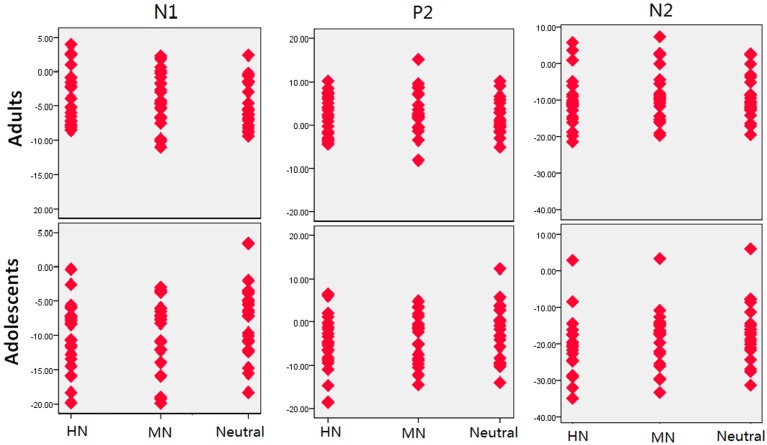
The scatterplot for the breakdown of the age and emotion interaction in the amplitudes of each component.